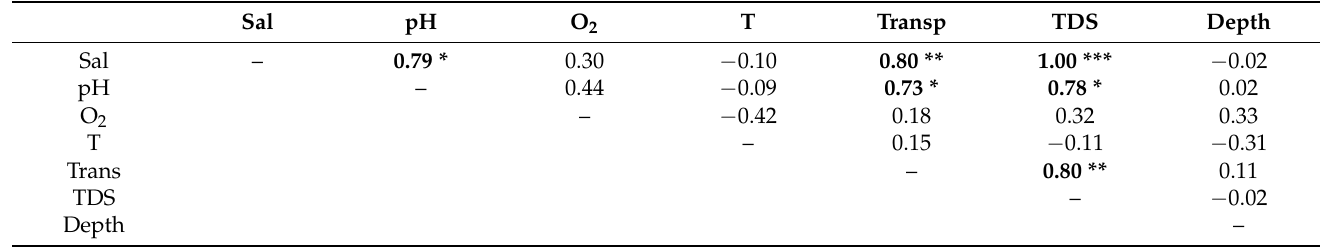
Table 3. Correlation matrix between the environmental variables on all five